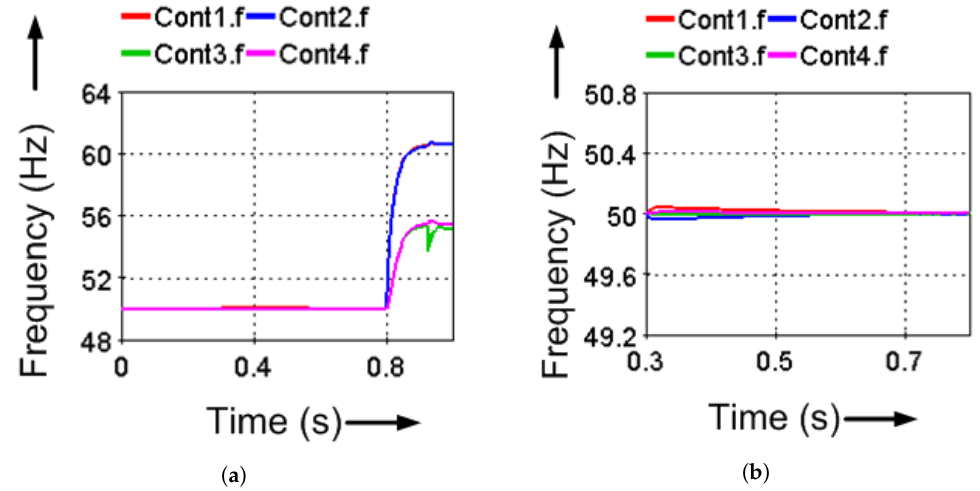
Figure 17. ( a ) Smart attack on ω ref initiated at 0.3 s; and ( b ) zoomed graph from 0.3 to 0.8 s of ( a